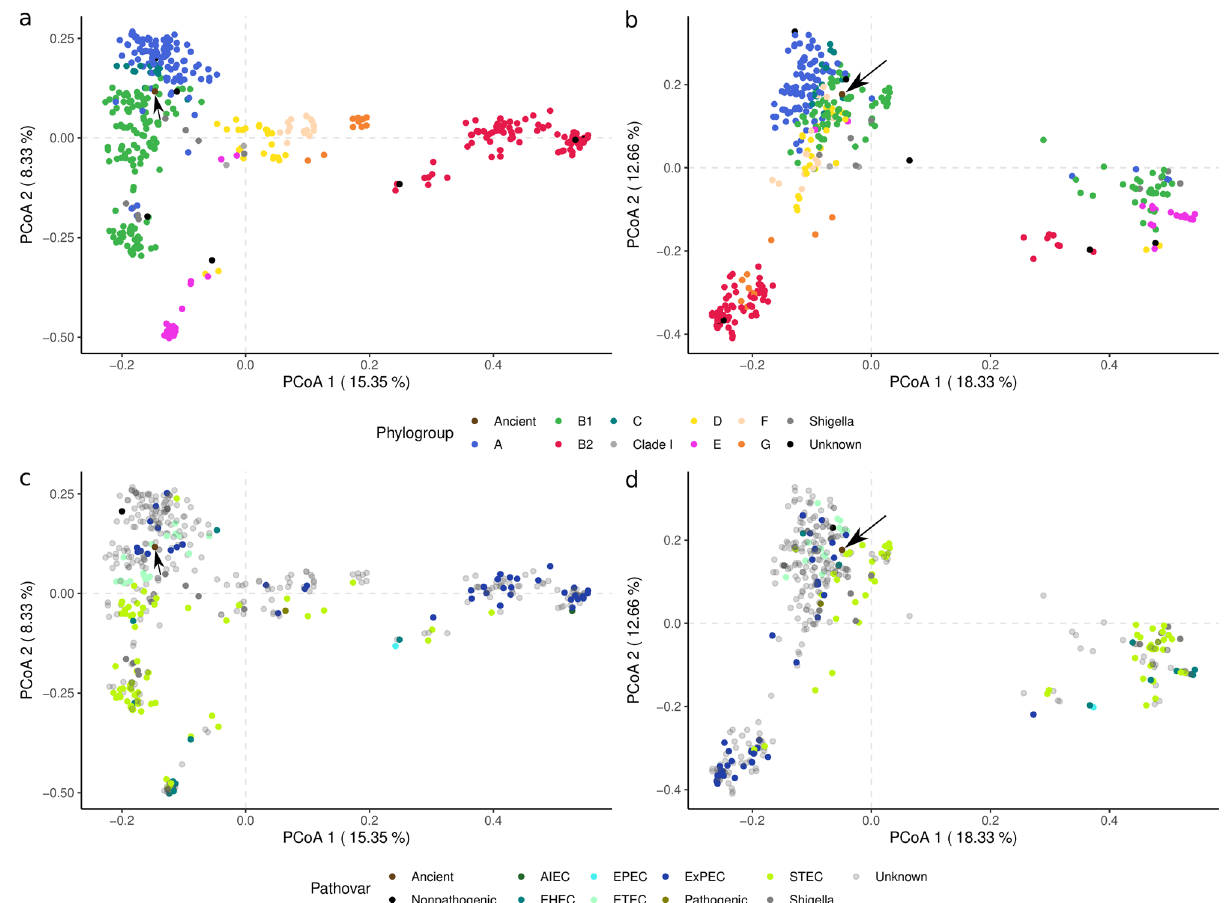
Fig. 4 Principal coordinate analyses (PCoA) of gene presence/absence data. The accessory genome ( a , c ) and identi fi ed virulence genes ( b , d ) were clustered using a binary distance. Phylogroups were identi fi ed using Clermont Typing 59 while pathovars were determined using available metadata from the Patric 49 database. The ancient genome is indicated by the black arrow. In both binary distances were calculated prior to create the PCoA.